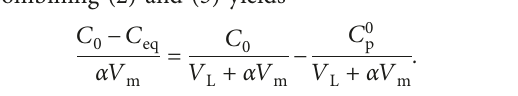
Table 1: Chemical compositions of the two pozzolanic cements.